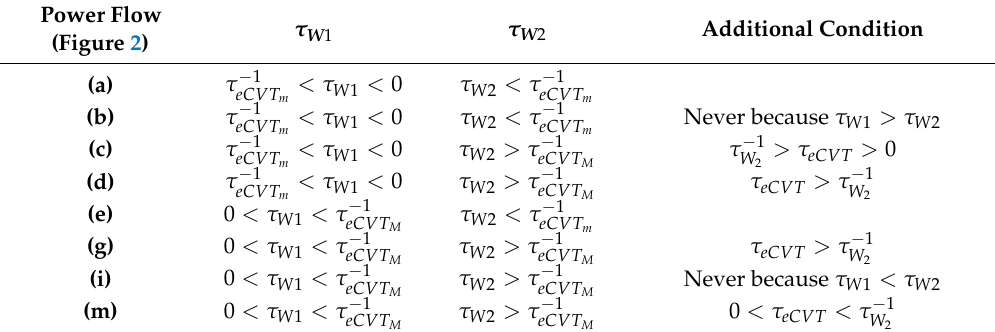
Table 9. Case 4—Power flows for each range of the planetary gear constants for τ eCVT > 0 . Power Flow